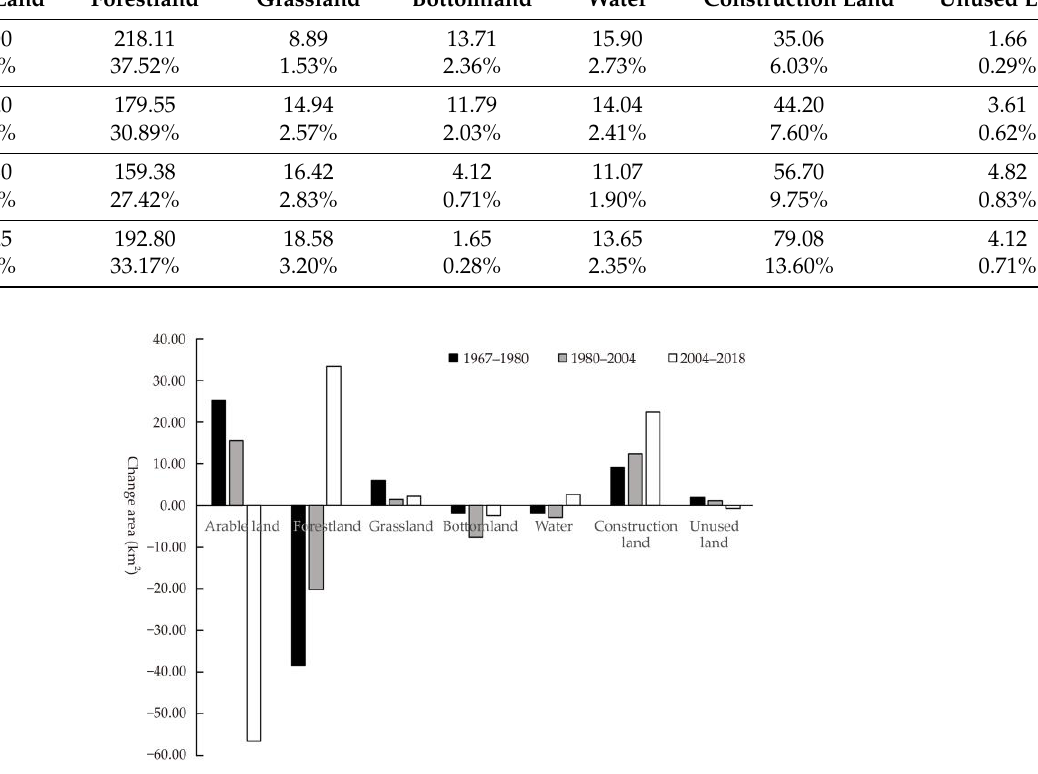
Figure 4. Land use transfer from 1967 to